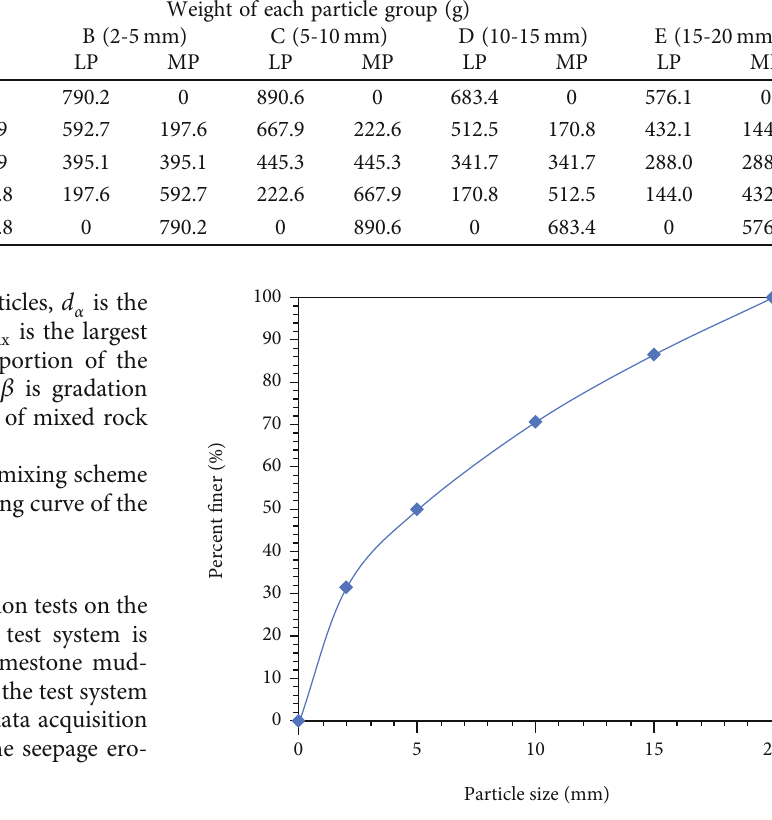
Figure 2: The gradation curve of the limestone and mudstone